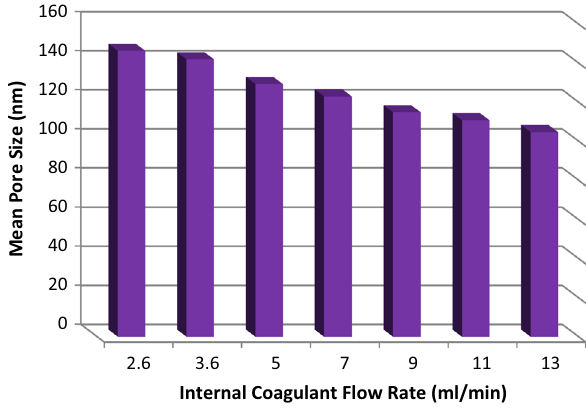
b Fig. 5 3D AFM images of the hollow fibers prepared from different effect of ICFR. a ICFR 2.6 ml/min; b ICFR 3.6 ml/min; c ICFR 5 ml/ min; d ICFR 7 ml/min; e ICFR 9 ml/min; f ICFR 11 ml/min; g ICFR